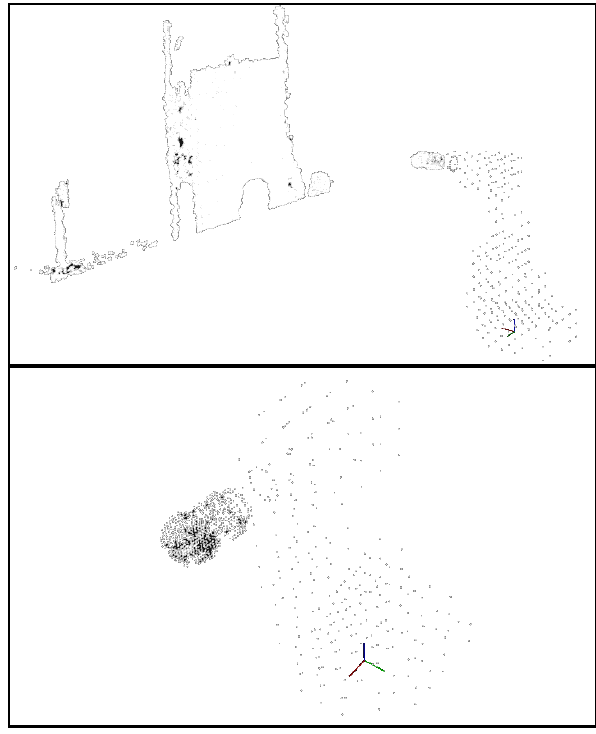
Figure 8: Example of different Octree resolutions on the